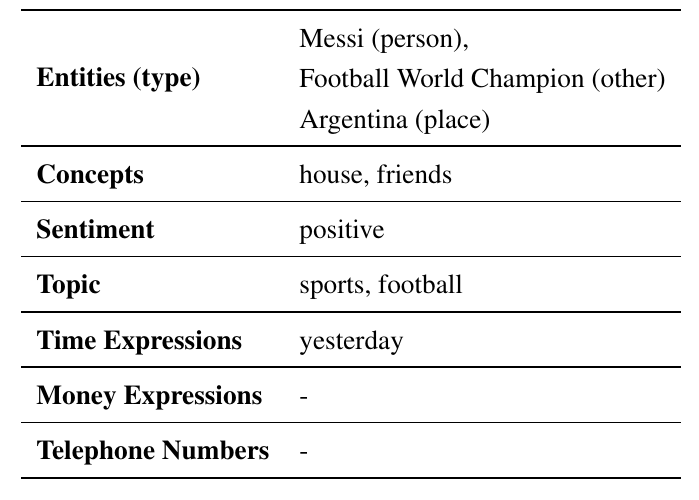
Table 2. Results obtained by the Information Extraction module from the user utterance: Hi! Yesterday, some friends and I were watching the Football World Cup at my house. Argentina’s game was great but Messi didn’t play